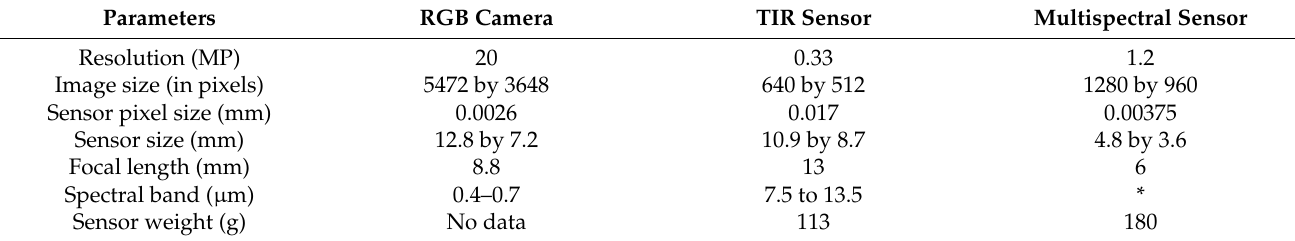
Table 2. Specifications of the UAV sensors used during the